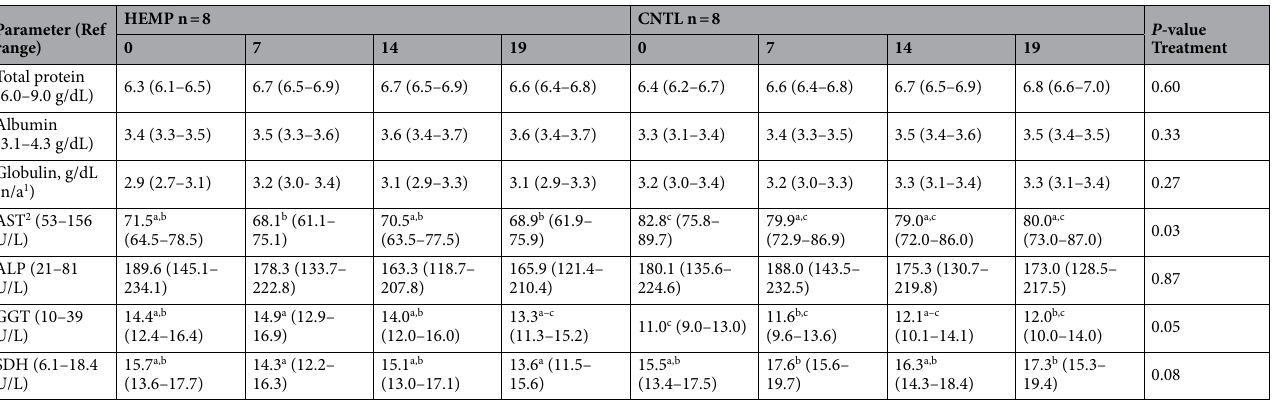
Table 5. Summary of mean (95% Confidence intervals) hepatic specific serum blood chemistry profiles prior to industrial hemp feeding and at 7, 14, and 19 days post feeding for cattle fed industrial hemp once a day for 14 days (HEMP) or control cattle (CNTL). a,b ,c Different letter within rows are significantly different ( P < 0.05). d n/a; calculated value. No laboratory reference given. e AST aspartate transaminase, ALP alkaline phosphatase, GGT gamma glutamyltrasferase, SDH sorbitol